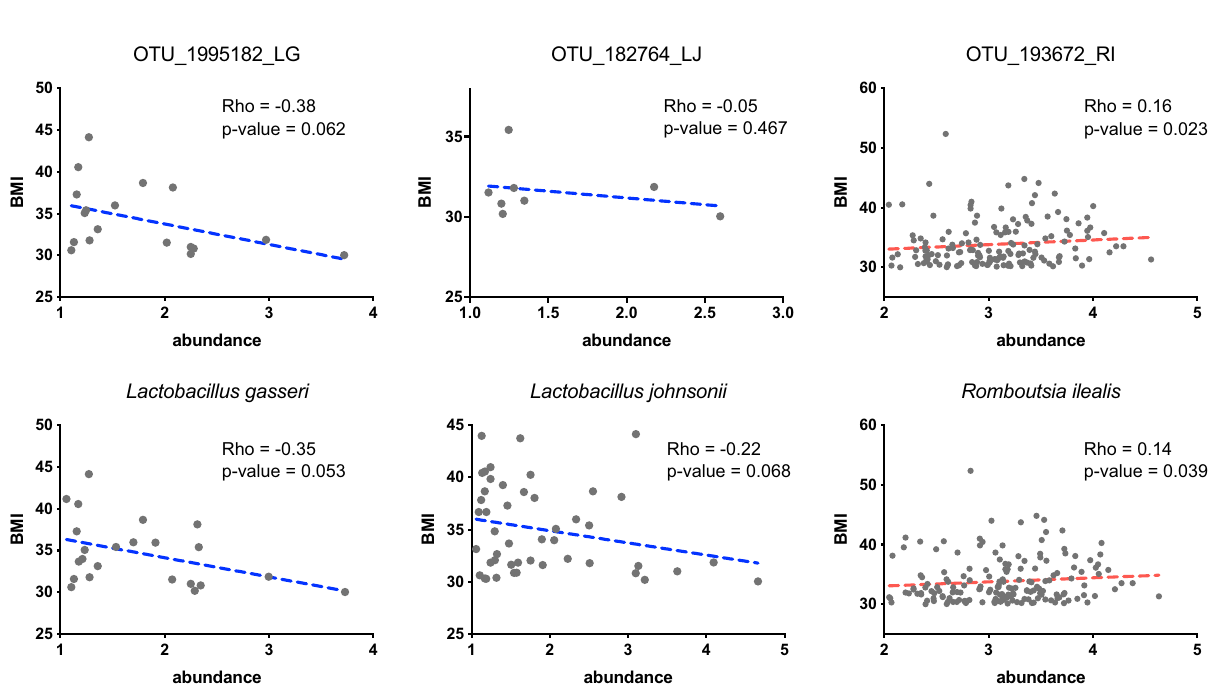
Fig. 2 Computational veri fi cation of predicted microbes in human data from the literature 26 . Each scatterplot shows the abundance of the microbes ( X axis) in stool versus the BMI of obese humans ( Y axis). The dotted line indicates the fi tted line. The Spearman rho correlation coef fi cient and one-tail p value is shown. Data retrieved from